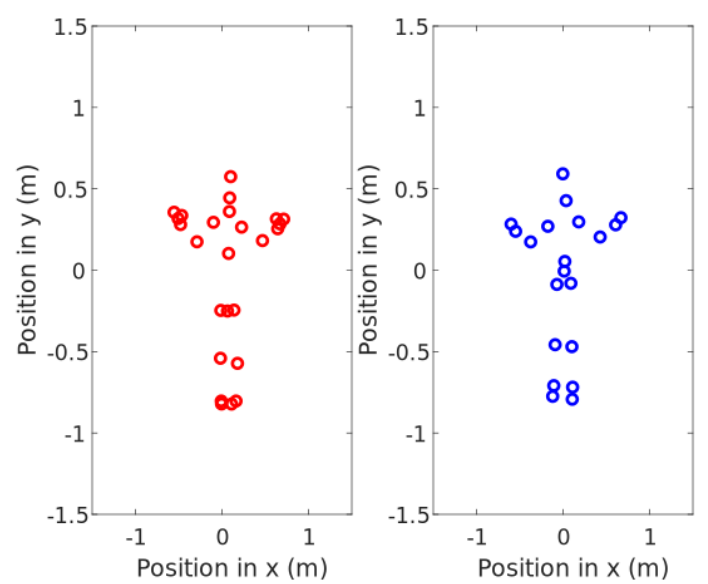
Figure 11. Joint coordinate projection for subject detection before 90 ◦ turn for lateral motion capture of Kinect V2 and V1 on (x,y) plane.